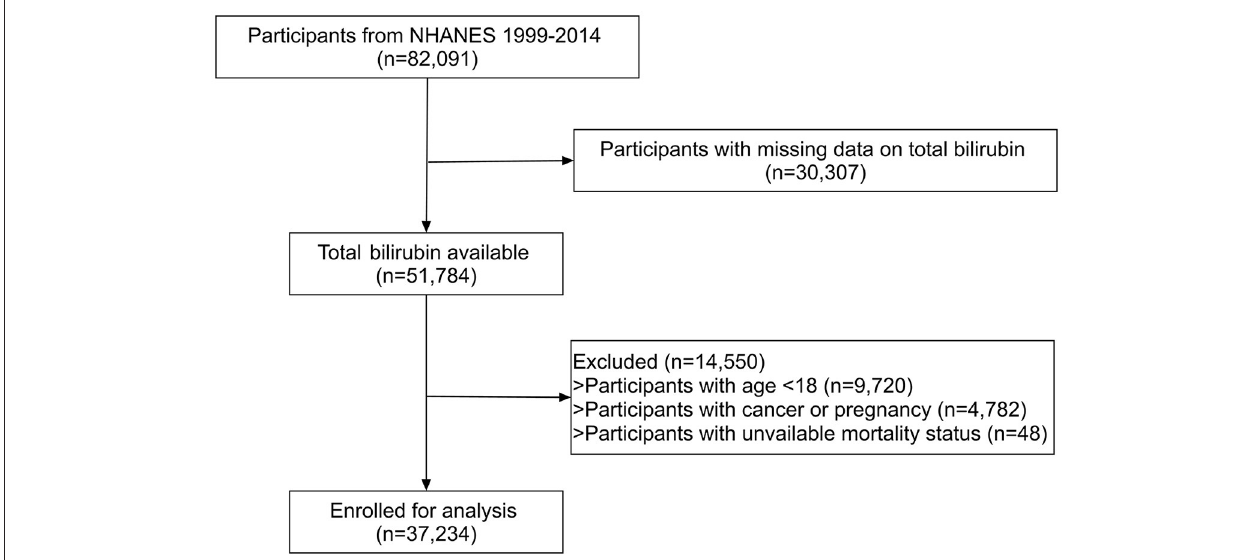
FIGURE 1 | The flow chart of participant